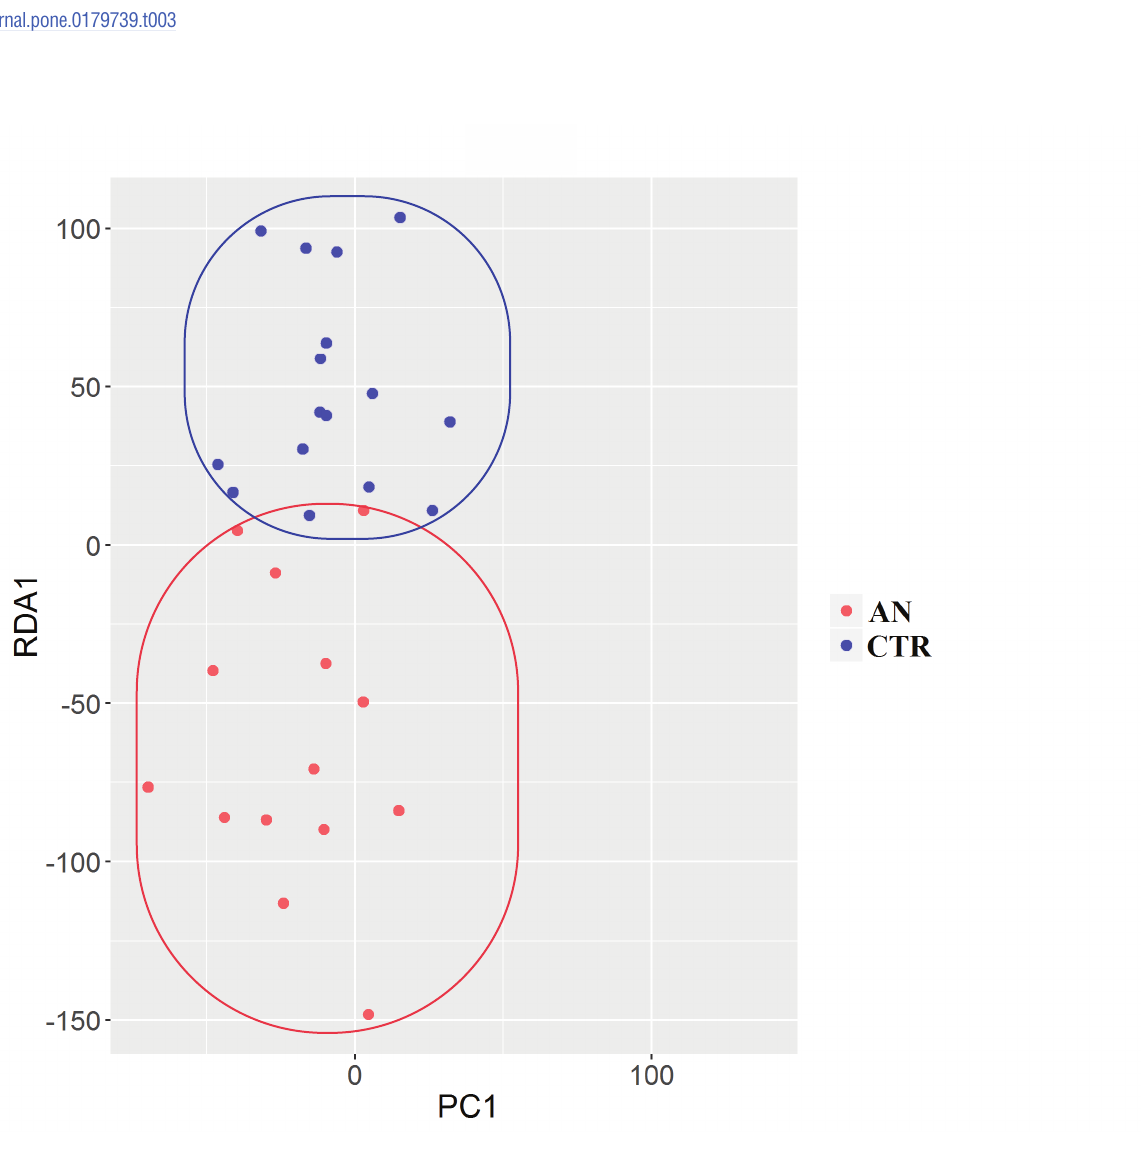
Fig 2. Redundancy analysis (RDA) of gut microbiota. RDA shows a separationbetweenanorexia nervosa (AN, red dots) and control (CTR, blue dots) subjects.